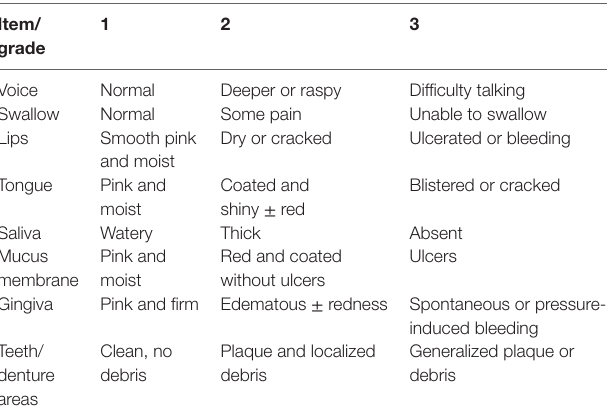
TAbLe 6 | Oral assessment guide (30).